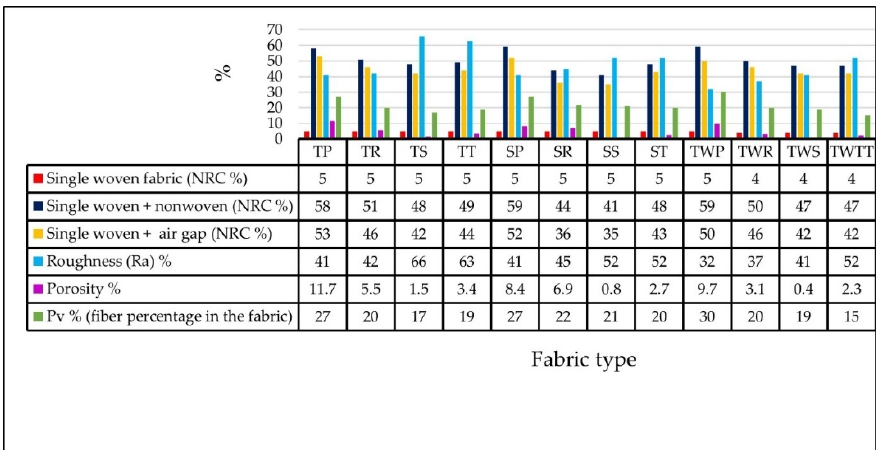
Figure 3. Noise reduction performance of the woven fabric and its relation to the characteristics of the fabric.